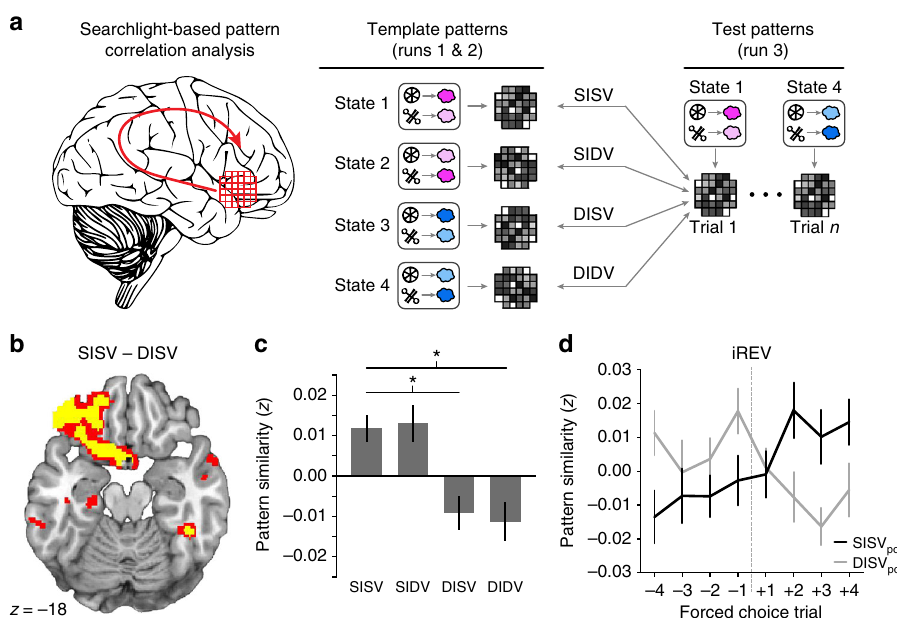
Fig. 5 fMRI patterns in OFC encode outcome identity expectations. a For each searchlight sphere, “ template ” patterns from CS-evoked activity of each task state were constructed using fMRI data from two of the three fMRI runs. In the “ left out ” run, the CS-related activity pattern on each trial was correlated with the four template patterns, and resulting correlation coef fi cients were labeled according to the relationship to the current state (SISV = same identity, same value; SIDV = same identity, different value; DISV = different identity, same value; DIDV = different identity, different value). Sorted correlation coef fi cients were Fisher ’ s z -transformed and mapped to the center voxel of the sphere to generate maps of pattern information content for group analysis. b Regions in the OFC encoding identity expectations, determined using the SISV – DISV contrast. Red = p < 0.005, uncorrected; yellow = p < 0.001 uncorrected. c Post hoc analysis of pattern similarity at the peak OFC voxel resulting from the SISV – DISV contrast revealed that there was also a signi fi cant difference between SISV and DIDV. Error bars depict within-subjects s.e.m. * p < 0.05, paired t -tests. d For illustration, pattern similarity values at the peak OFC voxel are shown for trials immediately before and after identity reversals (iREV). Correlations are depicted for SISV and DISV templates (relative